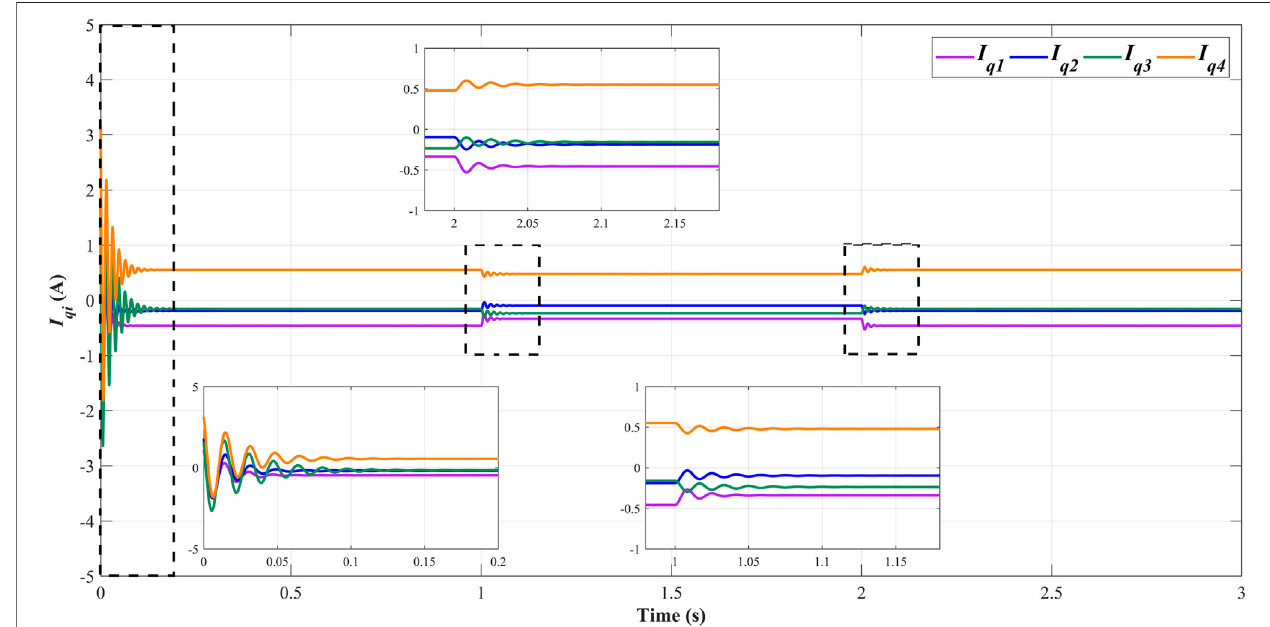
FIGURE 7 | Time evolution of the q -component of currents of interconnecting lines.